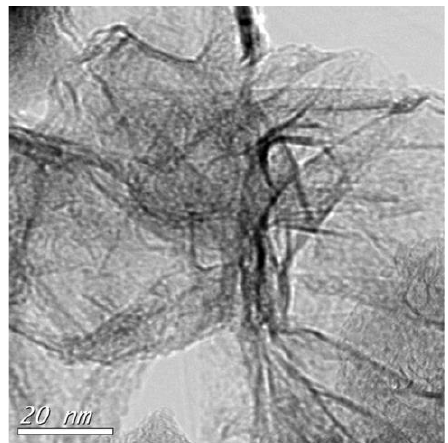
Figure 3. TEM image of multilayered graphene sheets in (Gr) sample. Produced by DC arc- discharge (scale bar 20 nm).